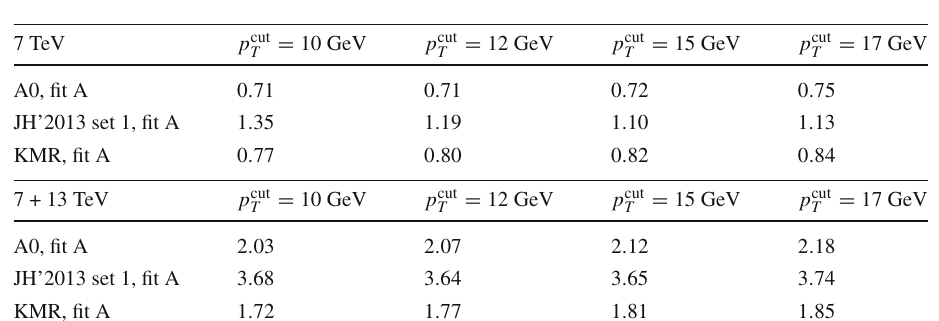
Table 3 The dependence of χ 2 / d . o . f . achieved in the fit procedure (the “fit A” scenario) on the choice of p cut at only √ T s = 7 TeV and at 7 and 13 TeV